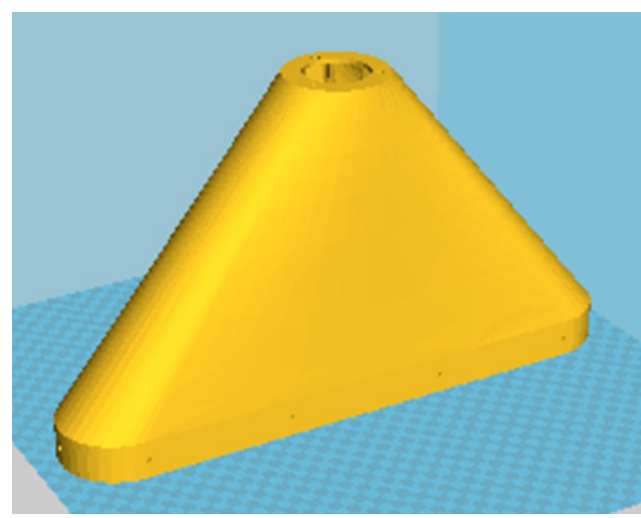
Figure 3. Herbicide shield.